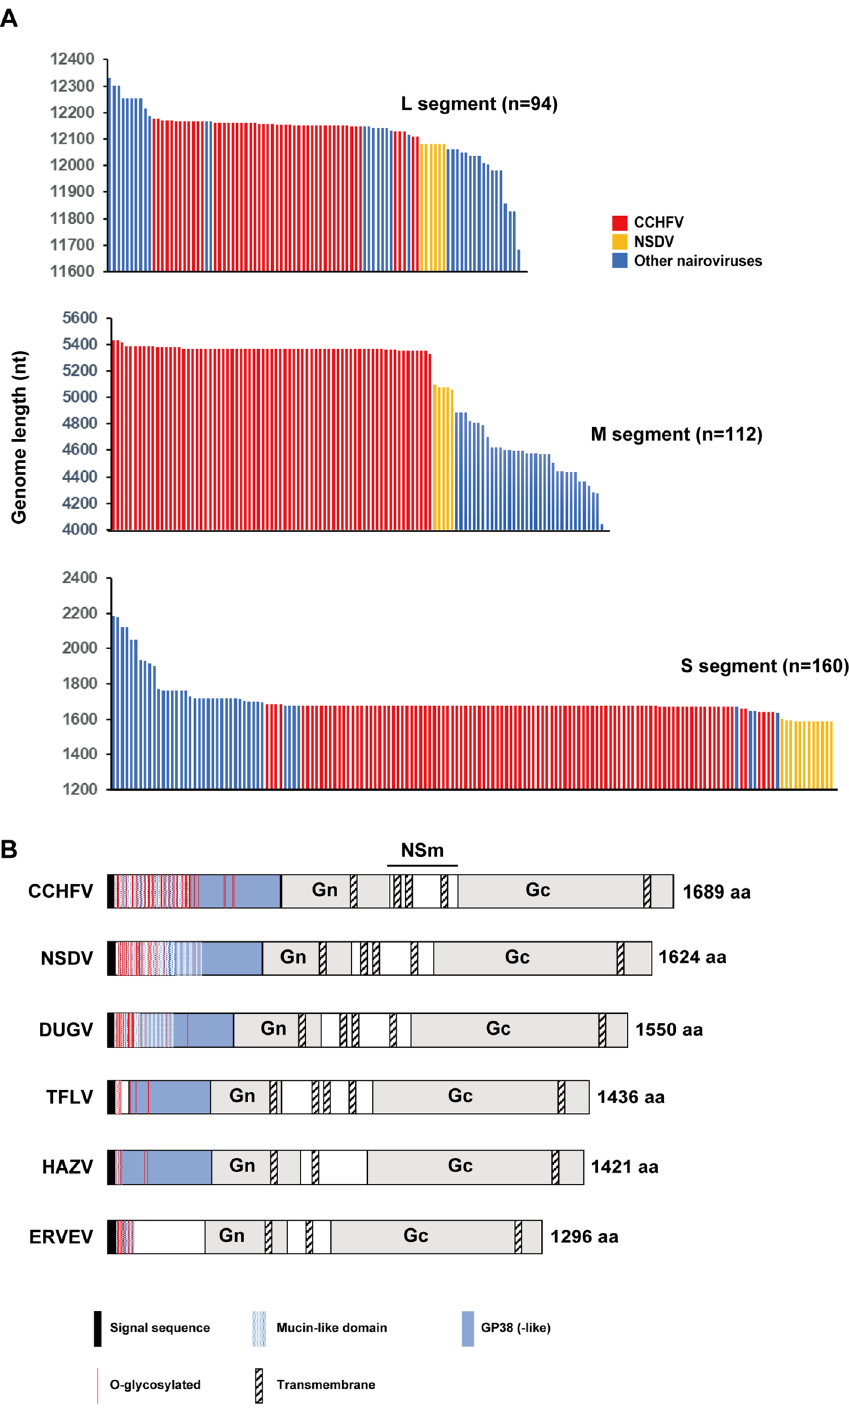
Figure 5. Genome length of virus species in the family Nairoviridae . ( A ) Genome length of each segment of nairovirus sequences (5 ′ -UCUC—GAGA-3 ′ ) registered in the NCBI Refseq database. Bars represent the precise sequence length of each virus. CCHFV and NSDV are shown in red and yellow. ( B ) Schematic diagram of GPC encoded in the M segment of nairoviruses. DUGV: Dugbe virus, TFLV: Tofla virus, ERVEV: Erve